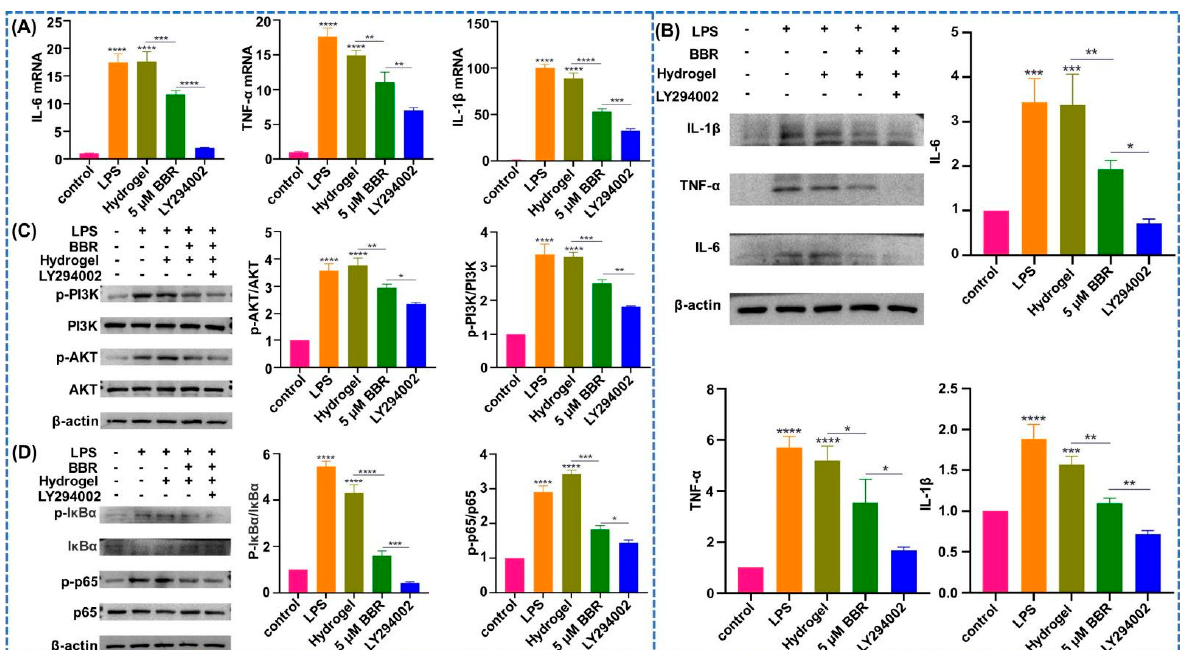
Figure 4. Anti-inflammatory effect of berberine thermosensitive hydrogel. ( A ) Change of IL–1 β , IL–6, and TNF– α mRNA expression; ( B ) Change of IL–1 β , IL–6, and TNF– α protein expression; ( C ) Protein changes in the PI3K/AKT pathway; ( D ) Protein changes in the nuclear factor kappa − B (NF −κ B) pathway. *: p < 0.05, **: p < 0.01, ***: p < 0.001, ****: p < 0.0001.